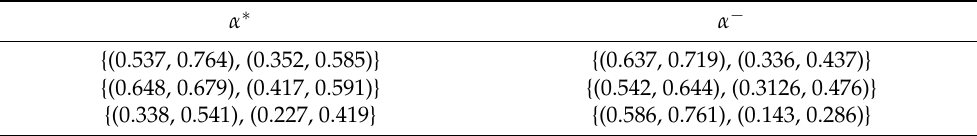
Table 3. Interval-valued intuitionistic fuzzy positive and negative ideal solutions.